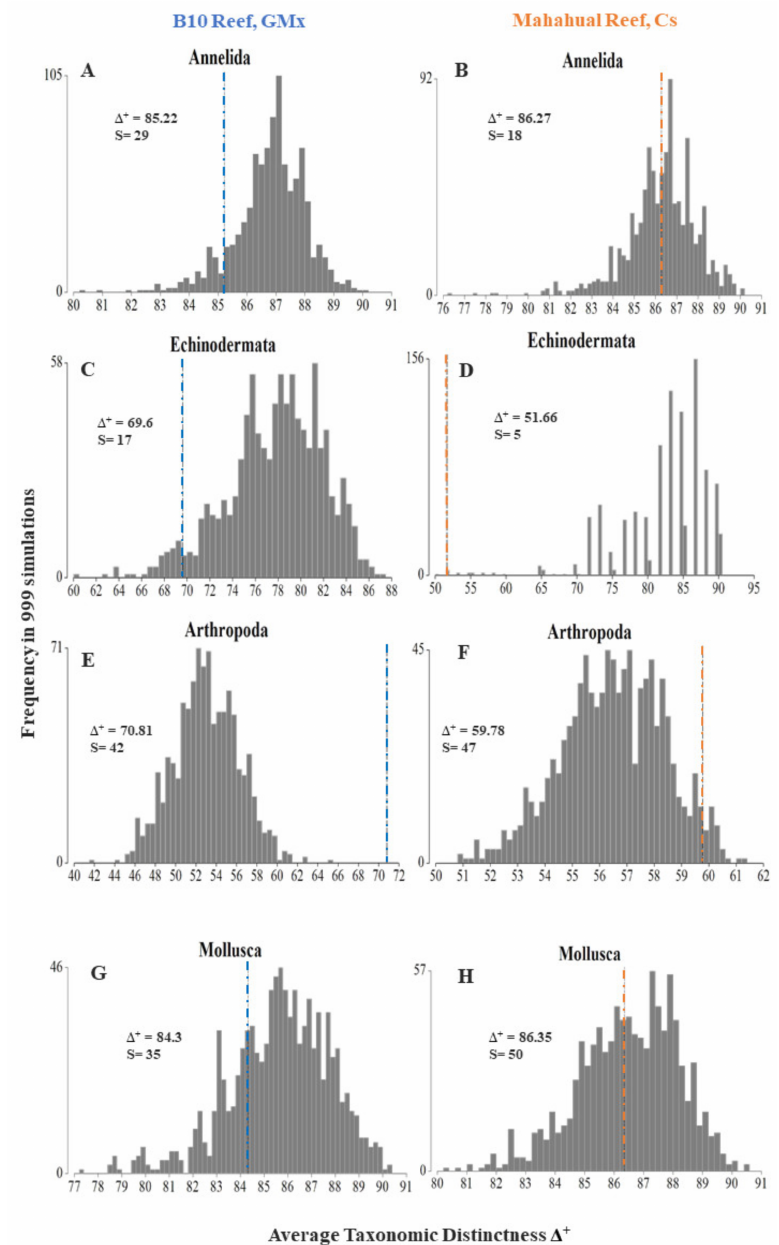
Figure 3. Frequency distribution of simulated ∆ + values generated from 999 sublists drawn randomly from the master list of species of each phylum by region: Gulf of Mexico ( A , C , E , G ) and Caribbean Sea ( B , D , F , H ) of the Yucatan Peninsula. Taxonomic aggregation matrices from OBIS and Felder and Camp [24]. The vertical colored lines are the estimation of ∆ + found in autonomous reef monitoring structures (ARMS) deployed during one year in each